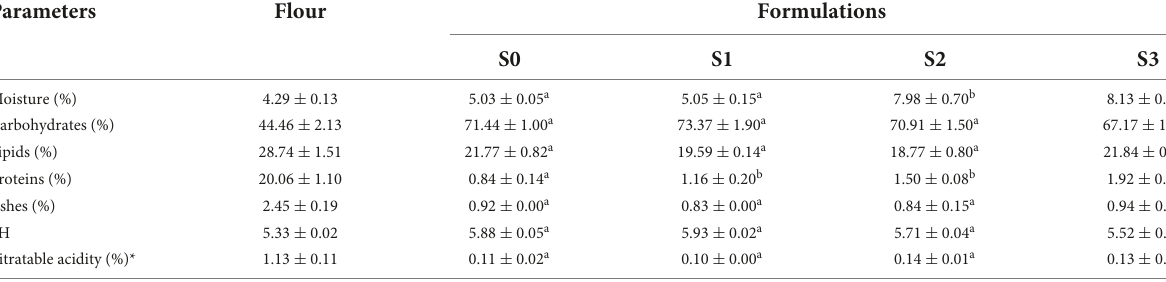
TABLE 2 Nutritional composition of macaúba almond flour and sequilhos-type biscuits per 100 g of product. Parameters